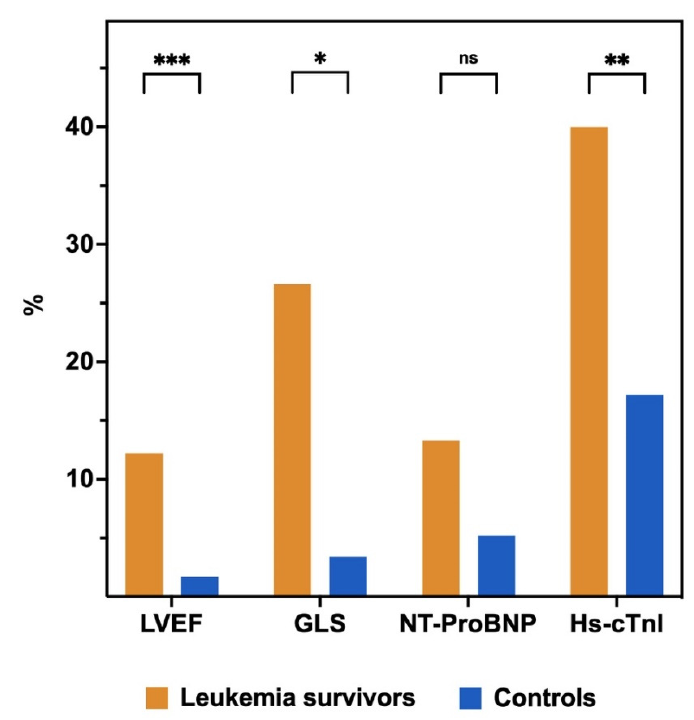
Figure 2. Prevalence of left ventricular systolic dysfunction and biomarkers abnormalities in leukemia survivors and controls. Cut-off values were LVEF < 50%, GLS < 18.5%, NT-ProBNP > 125 pg/mL, and Hs-cTnI > 2.5 ng/L. * p < 0.001, ** p < 0.01, *** p < 0.05. ns, Not significant.